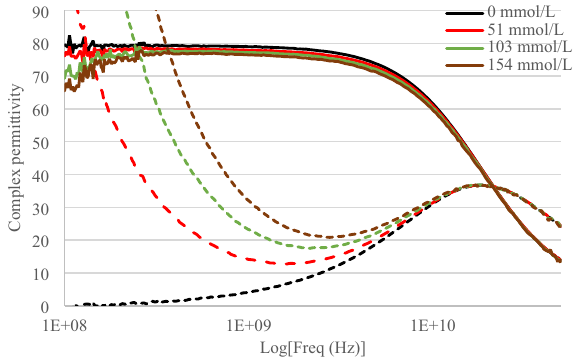
Figure 2. Real part (solid line) and imaginary part (dashed line) of the complex permittivity as a function of frequency (logarithmic scale) for various sodium chloride concentrations.